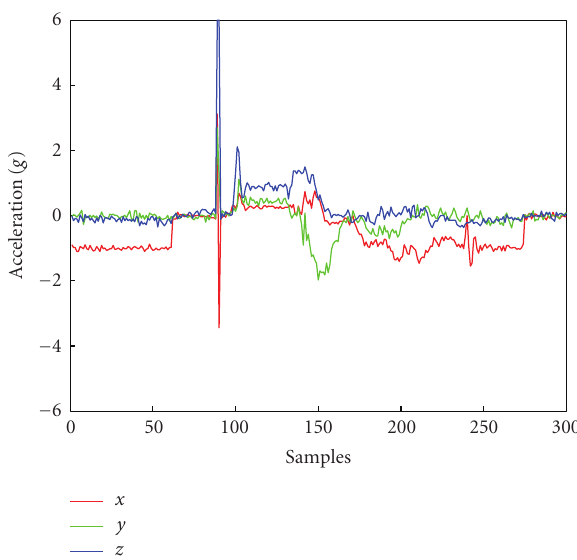
Figure 5: Nokia 5500 accelerometer data (phone dropped).